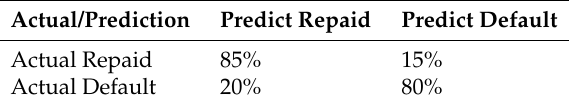
Table 8. Confusion matrix of random forest model for